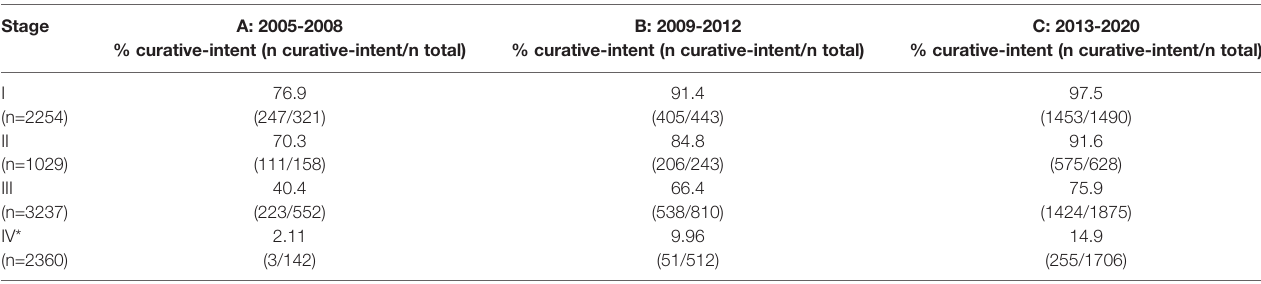
*Patients with oligometastatic disease treated with curative